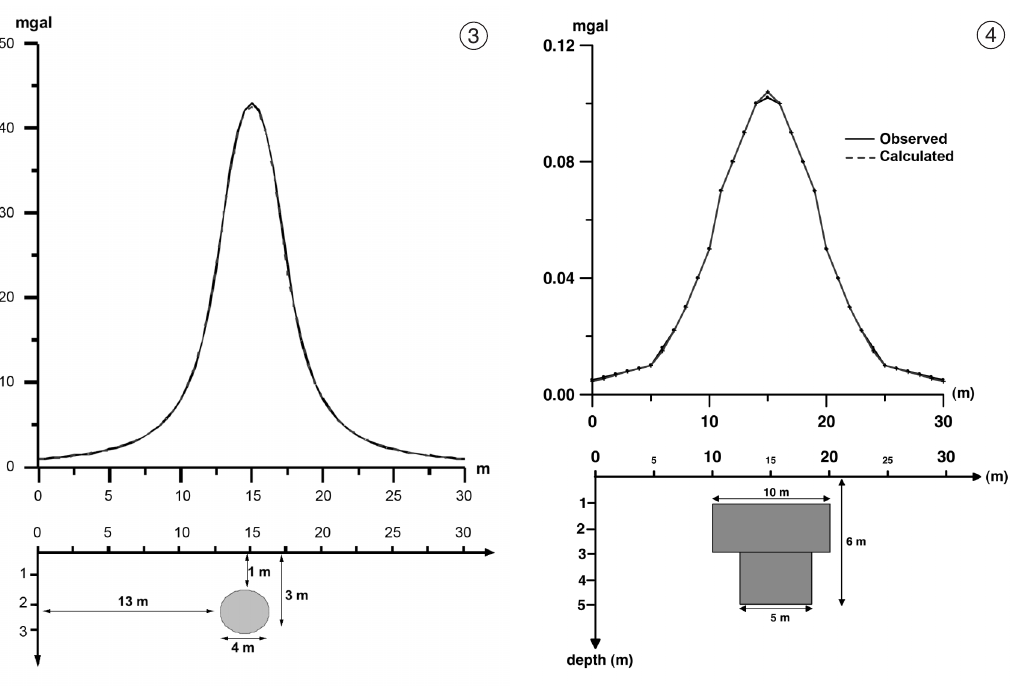
Fig. 3. Results of FNN for synthetic horizontal cylinder. Fig. 4. Performance of FNN for synthetic T -type prismatic